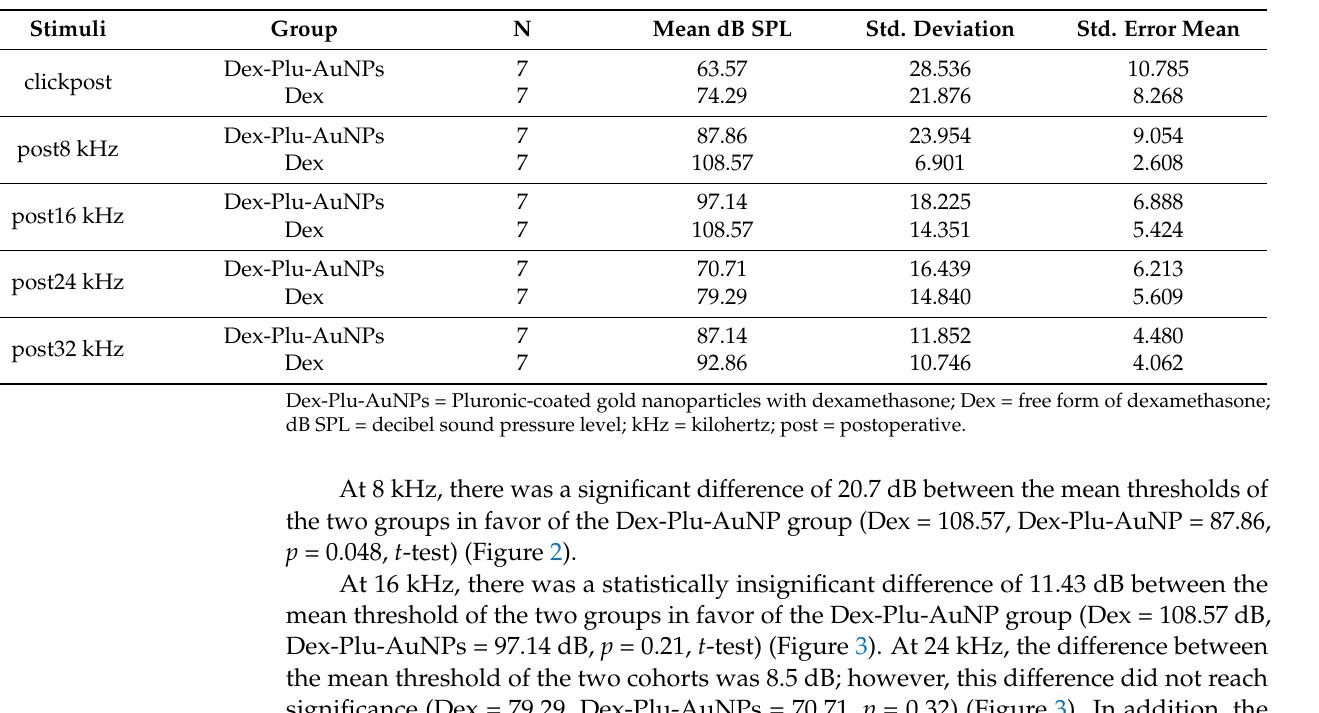
Table 2. Postoperative frequency-specific hearing threshold (SPL dB) for both the Dex-Plu-AuNP and Dex